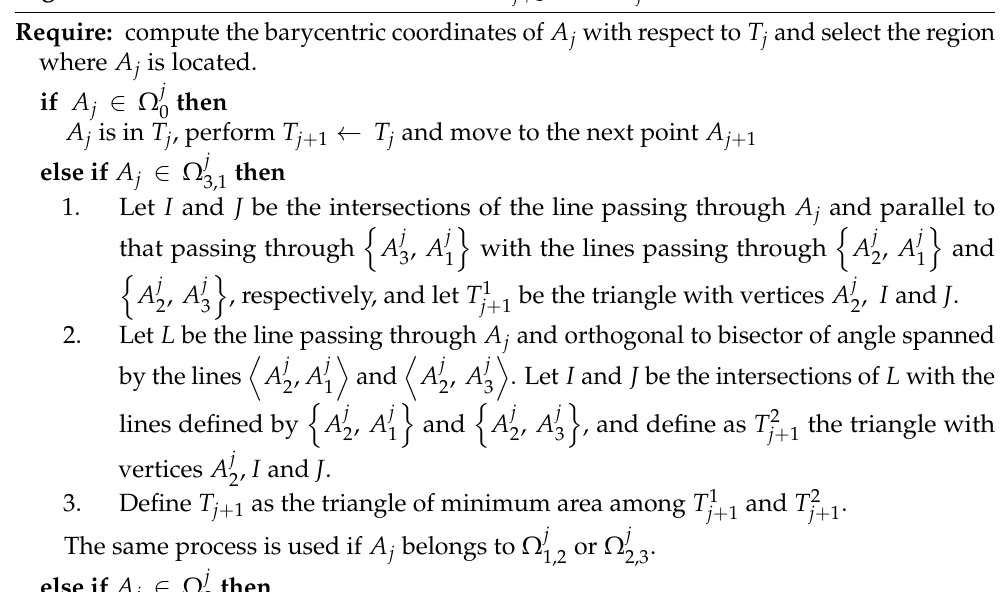
Algorithm 1 D ETERMINING THE TRIANGLE T j + 1 FROM T